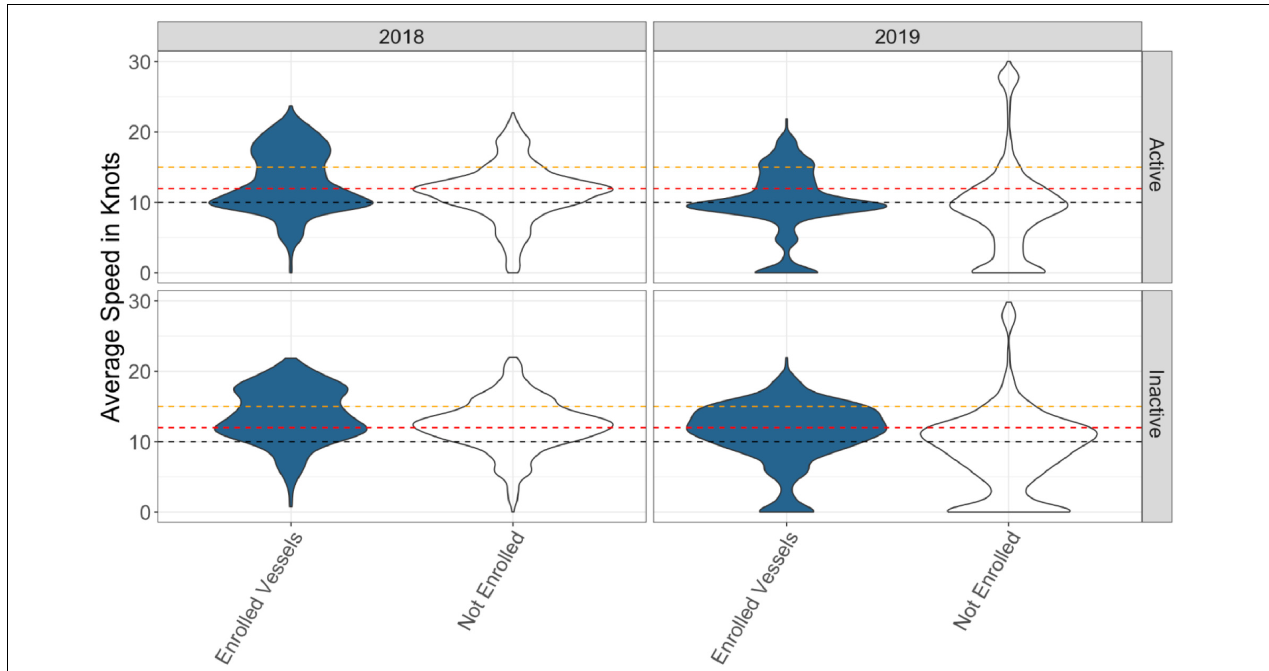
FIGURE 6 | Average speed of transits by vessels enrolled in the Protecting Blue Whales and Blue Skies Program vs. vessels not enrolled in the program across voluntary VSR zones during 2018 and 2019 inactive and active time periods. The width of the filled region of the plots is proportional to the number of transits. Black dotted line represents 10 knots, red dotted line represents 12 knots, and yellow dotted line represents 15 knots. TABLE 3 | Nautical miles traveled, mean speed over ground, and % cooperation of enrolled vessels in the Protecting Blue Whales and Blue Skies Program’s southern California VSR zones across 2018 and 2019 and across active vs. inactive time periods. Year VSR status Nautical miles Mean speed over % cooperation (total distance at % change in cooperation, inactive traveled ground (kts) 10 kts or less) vs. active time periods 2018 Inactive 142,353 14.4 12% + 20% Active (7/1 -11/15) 100,044 13.5 32% 2019 Inactive 111,858 14.6 11% + 41% Active (5/15/-11/15) 137,113 12.1 52% Timelines varied year to